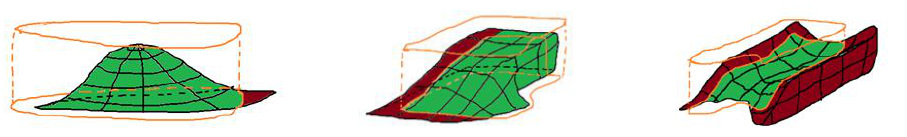
Figure 14. Relationship between segmentation errors regarding footprint and volume for different error types and pile shapes; illustration. error types and pile shapes;